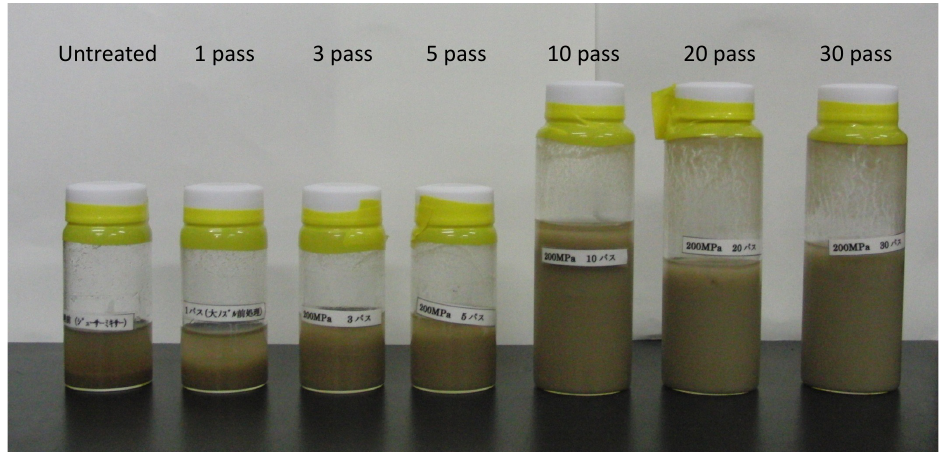
Figure 1. Pretreatment of 2% sugarcane bagasse with the wet jet milling device. 2% (w/v) sugarcane bagasse was pretreated using the wet jet milling device under 200 MPa (Star Bust®, SUGINO Machine Ltd., Toyama, Japan) from 1 to 30 passes and without it.